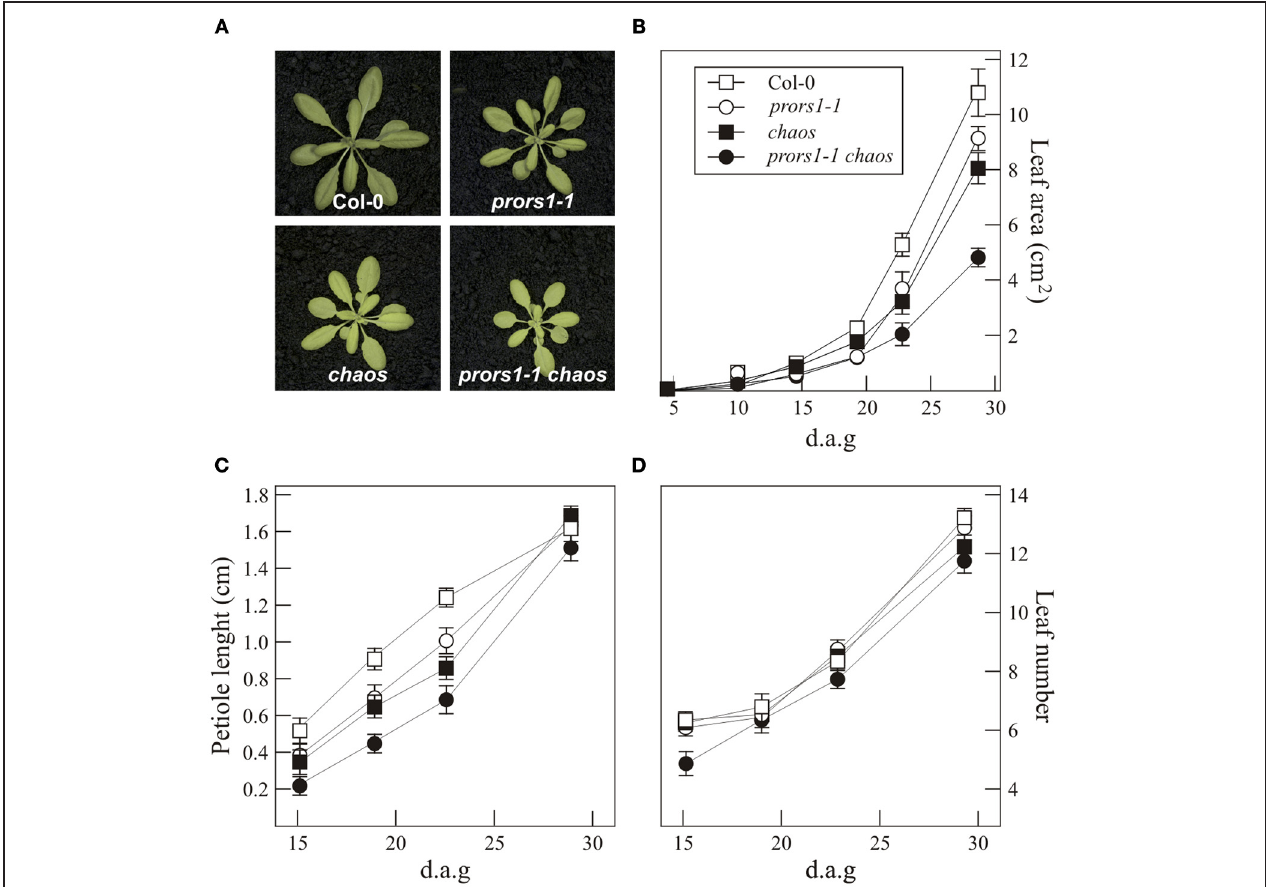
leaf from 15 to 28d.a.g. (D) The number of true leaves was determined during the period from 15 to 28d.a.g. Each point reported in (B) , (C) , and (D) is based on the determination of average leaf area, petiole length and leaf number, respectively, in at least 12 individuals. Bars indicate standard